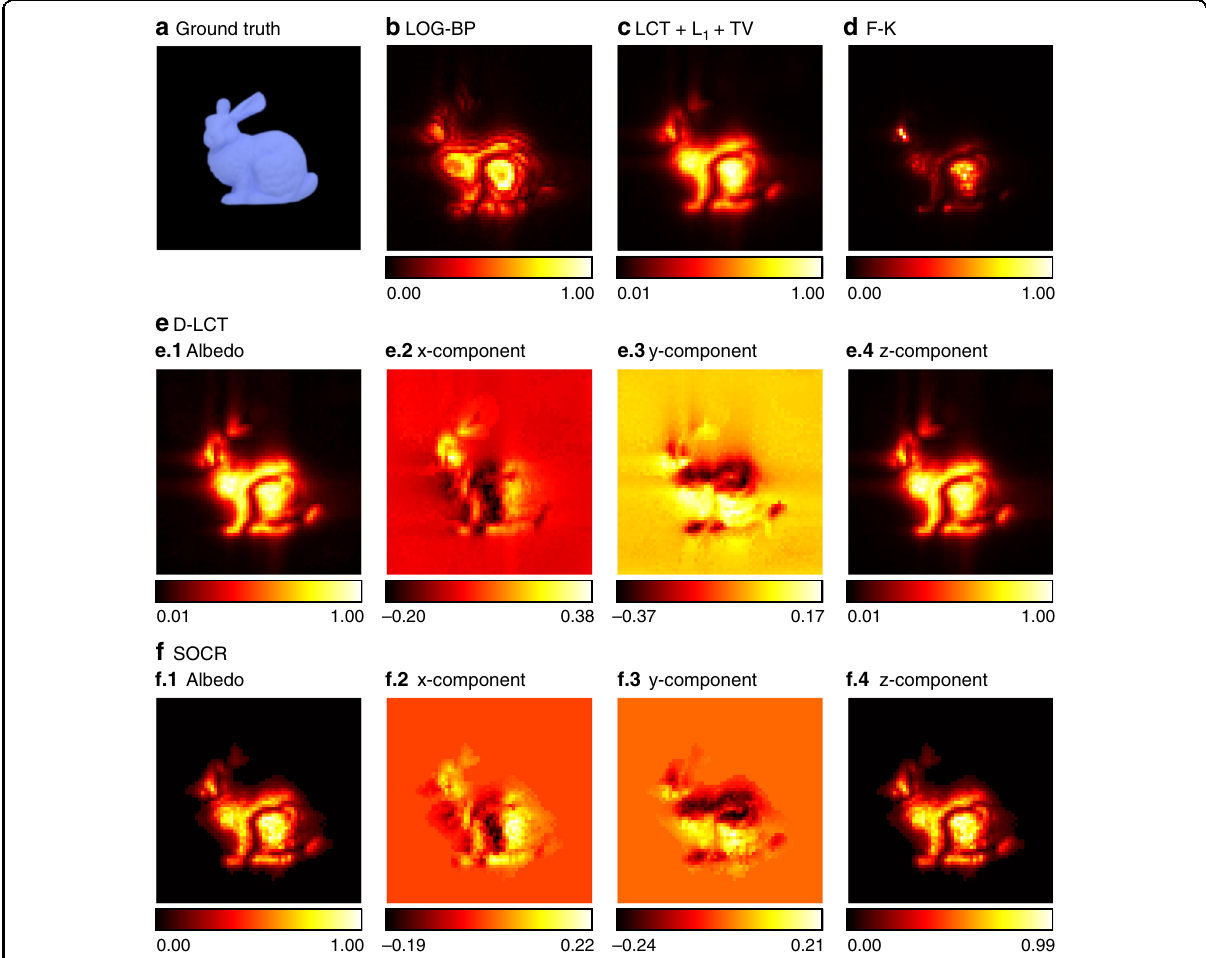
Fig. 4 Reconstruction results of the Stanford bunny (confocal). The ground truth is shown in a . Reconstructions are shown in b – f . The proposed method provides a sparser reconstruction than the D-LCT algorithm, and the boundary is much sharper than the one given by LCT + L 1 +